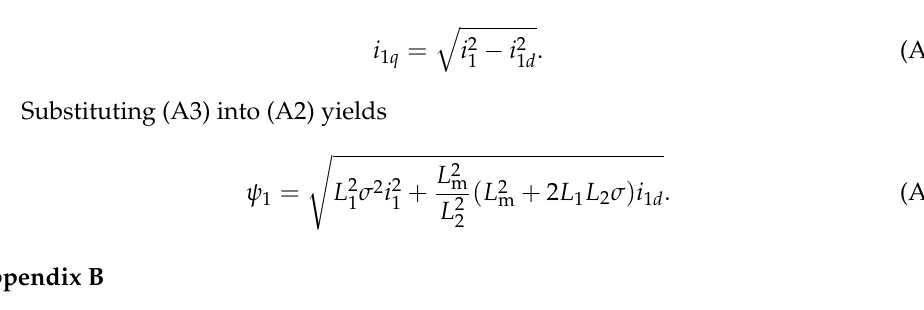
Table A1. Induction motor nameplate data and mathematical model